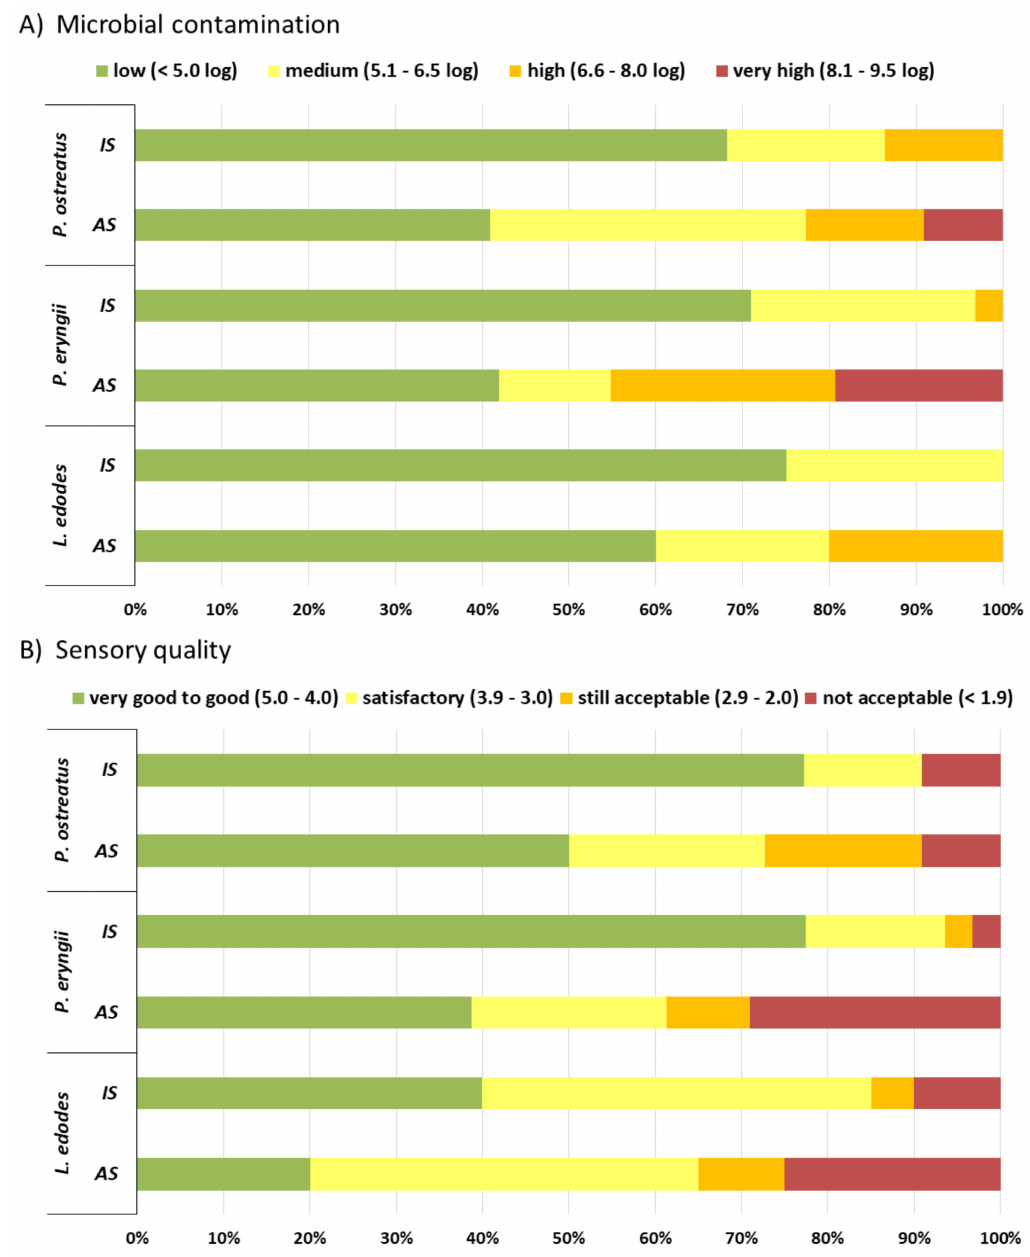
Figure 2. Categorization of microbiological and sensory quality of cultivated mushroom species ( A , B ). Percentage (%) of tested samples among several ranges of ( A ) aerobic mesophilic count (AMC) and ( B ) score of sensory quality (QS) analysed on the day of purchase (IS) and after storage